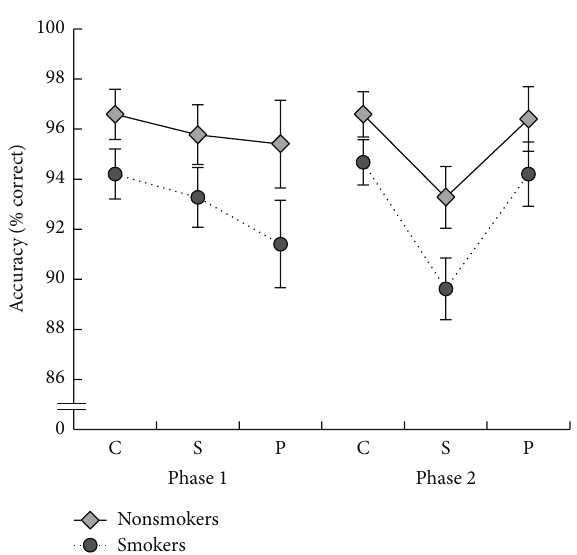
Figure 1: The mean % accuracy and standard error of the mean (SEM) for each stimulus condition (c, s, and p) for smokers and nonsmokers in phases 1 and 2 of the experiment.